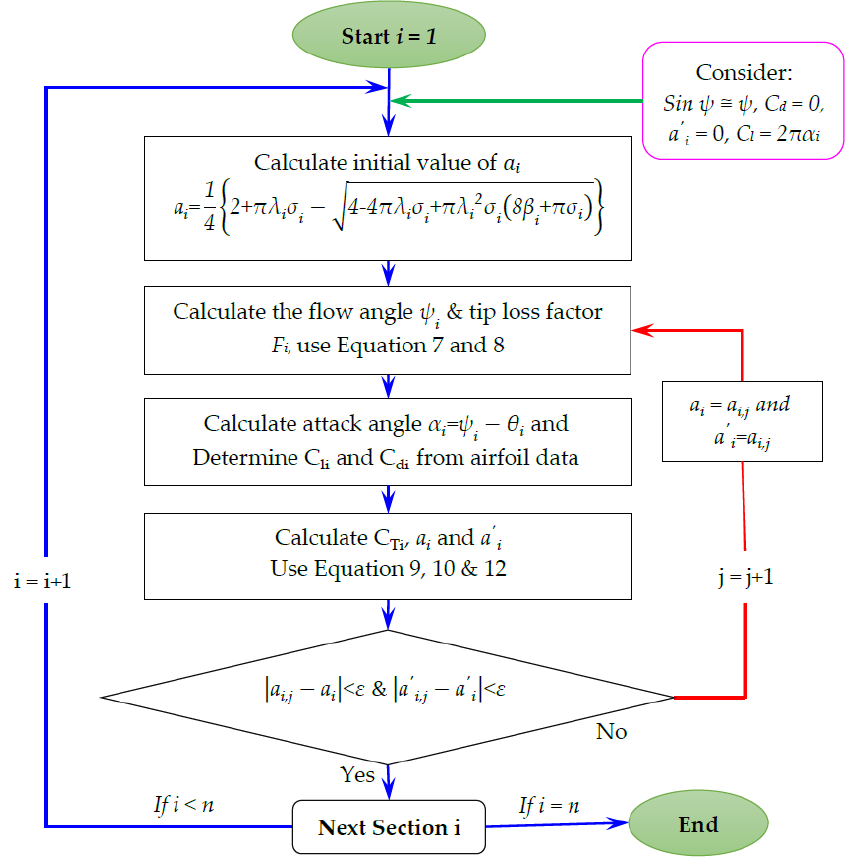
Figure 10. The code flow diagram and steps involved in stage of BEM.